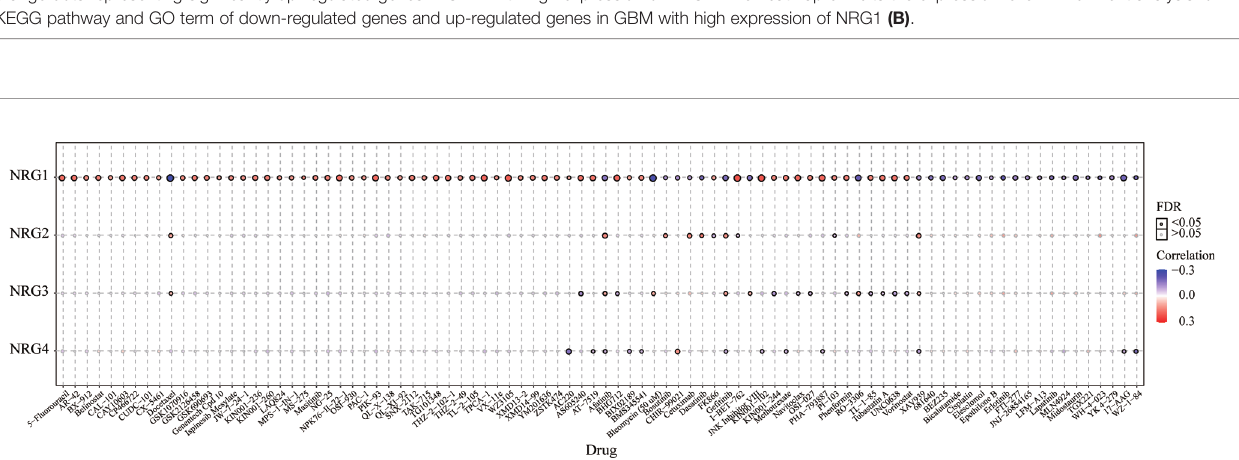
FIGURE 14 | GDSC drug sensitivity analysis. Correlation between NRG1-4 expression and GDSC drug sensitivity in